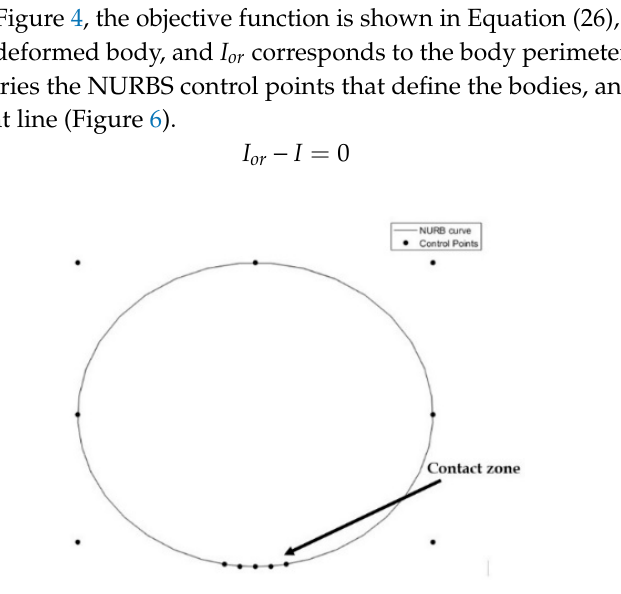
Figure 6. Contact zone and control points.